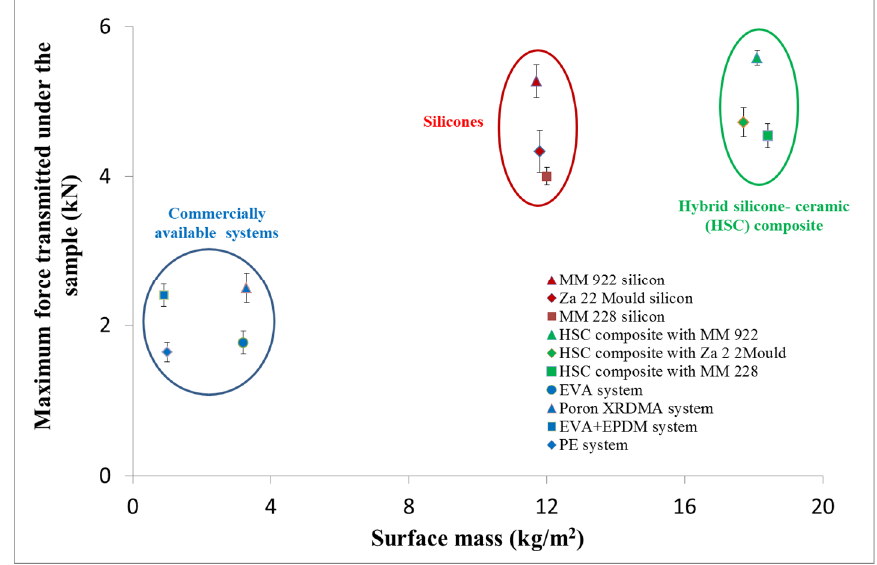
Figure 6. Dependence of the maximum force transferred to the sample on the surface mass of the tested composite systems. Table7. Impact test results for the impact energy of 5 J.